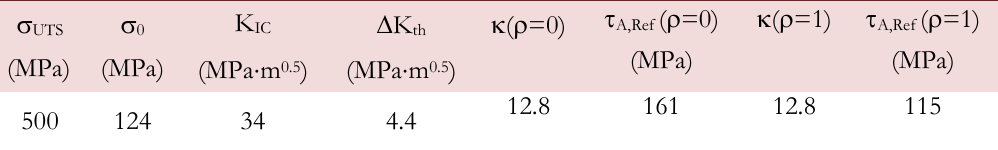
Table 1: Constants for the methodology for Al alloy 4%